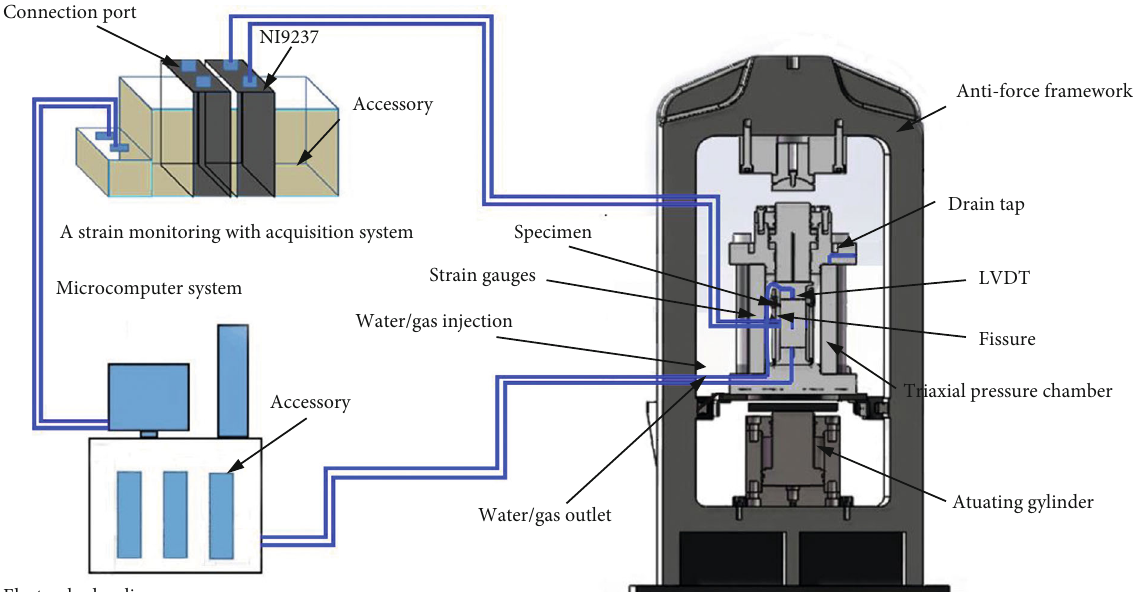
Figure 2: THMC coupling test system (after [34]).